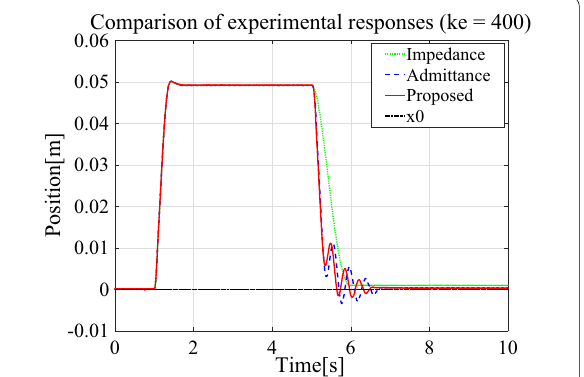
Fig. 10 Transient response of displacement of the control object